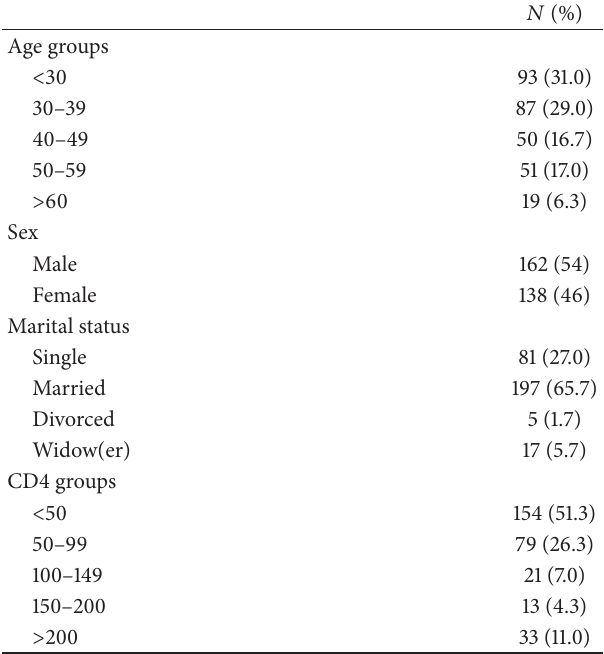
Table 1: General characteristics of 300 patients with CNS